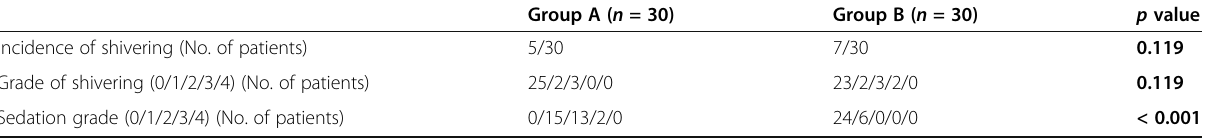
Table 2 Incidence and grade of shivering, grade of sedation Group A ( n = 30) Group B ( n = 30) p value Incidence of shivering (No. of patients) 5/30 7/30 0.119 Grade of shivering (0/1/2/3/4) (No. of patients) 25/2/3/0/0 23/2/3/2/0 0.119 Sedation grade (0/1/2/3/4) (No. of patients)